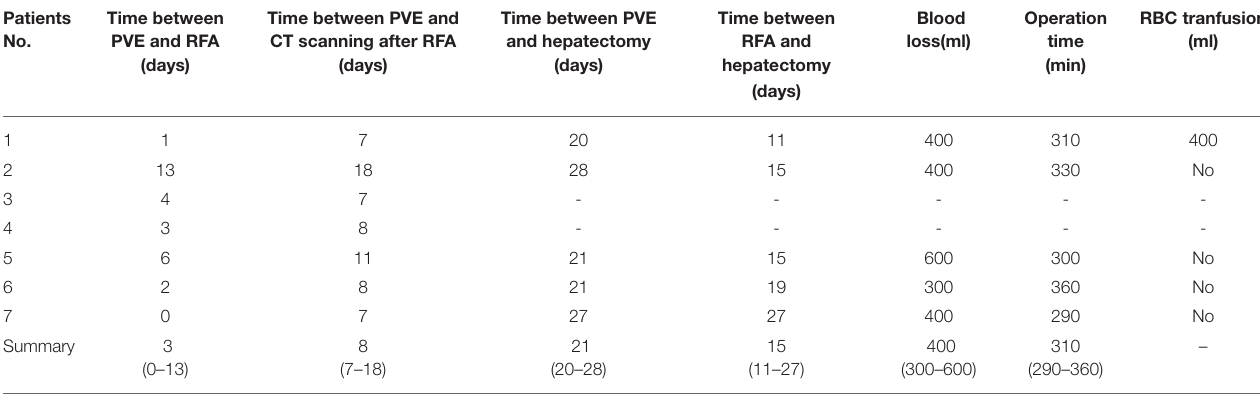
TABLE 4 | PVE + RFA and liver resection related information. Patients